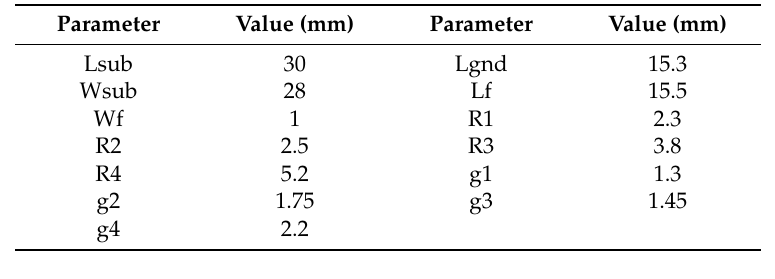
Table 1. Dimensions of the proposed quad-notched ultra-wide band (UWB) antenna.